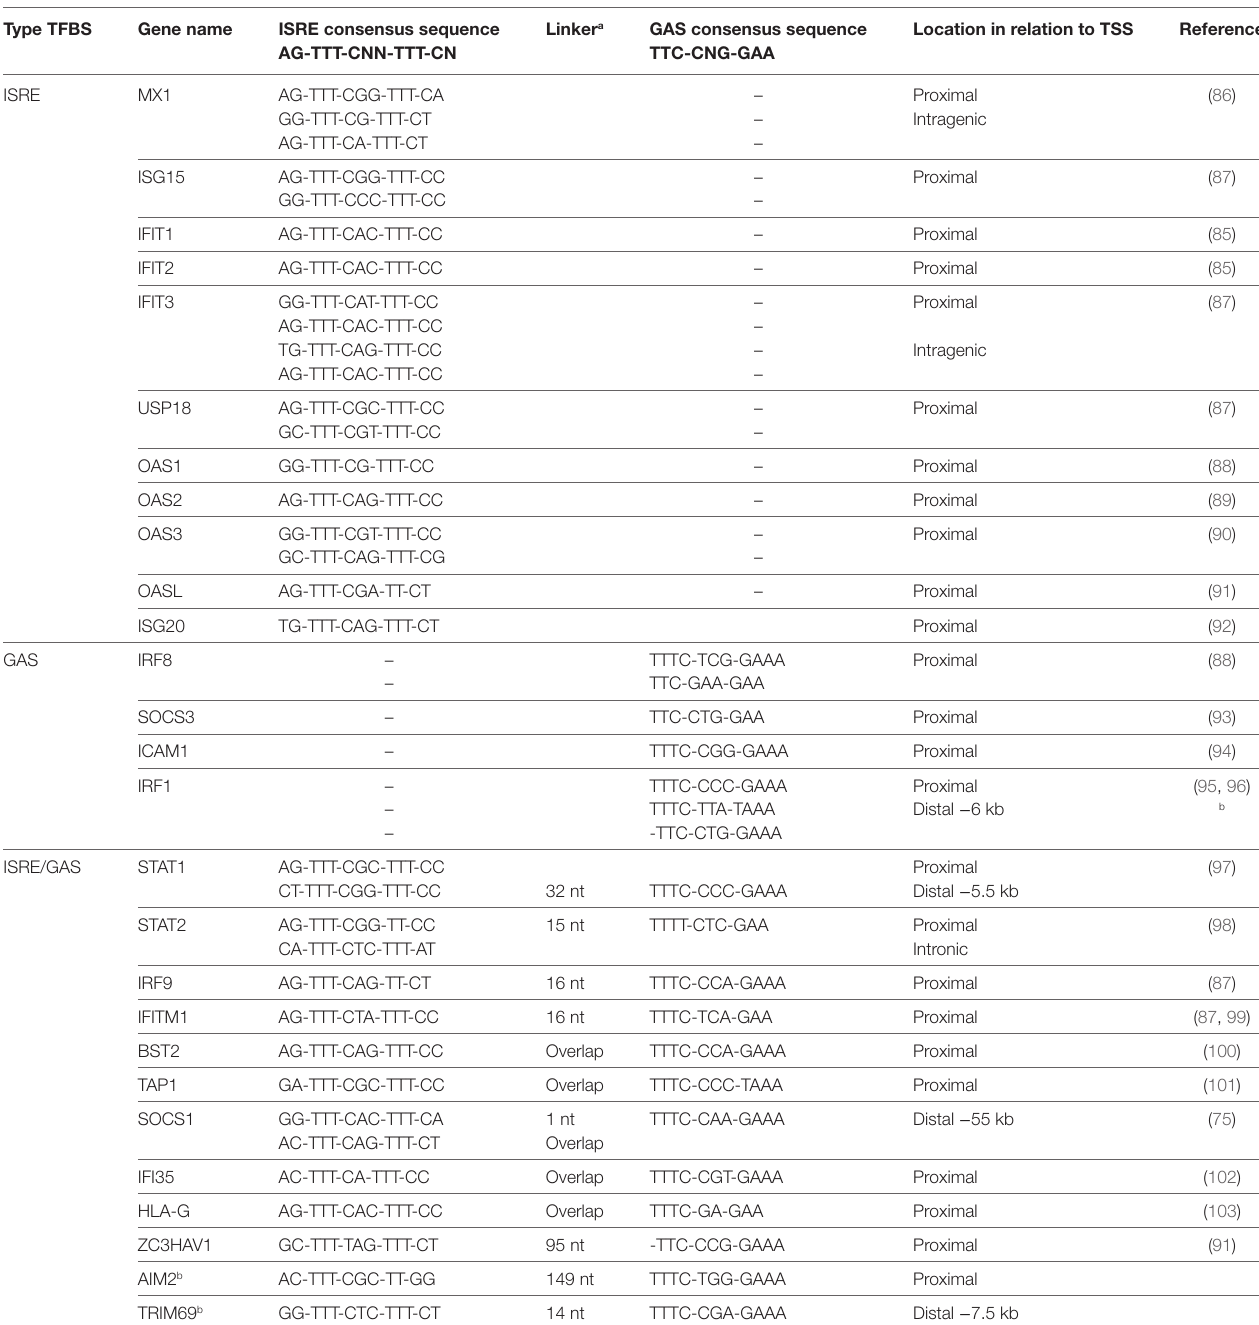
taBLe 1 | ISRE and GAS sequences of known